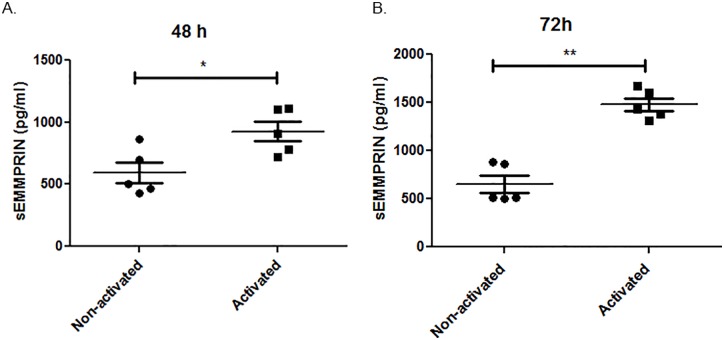
Increased sEMMPRIN secretion upon T-cell activation.PBMCs were isolated from five healthy subjects on three separate occasions and the T-cells were activated with anti-CD3 and anti-CD28 antibodies for 48 or 72h, or were left non-activated for the same time period. Conditioned media analyses found that activation of T-cells resulted in a progressive increase of sEMMPRIN level. The dots represent results from individual subjects, performed in duplicate. Comparison between the groups were done by Student’s t-test, *p<0.05 and **p<0.01. Values are represented in mean pg/ml ± SD.